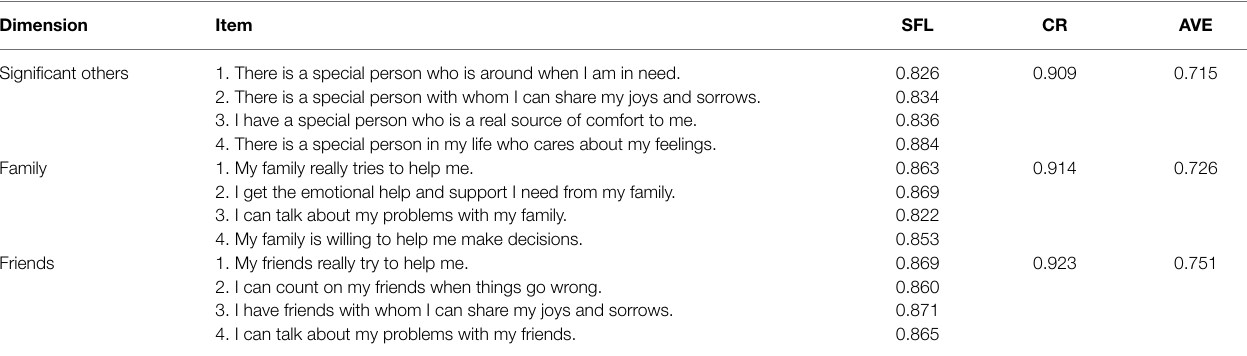
TABLE 2 | CFA of the perceived social support scale. Dimension Item Significant others